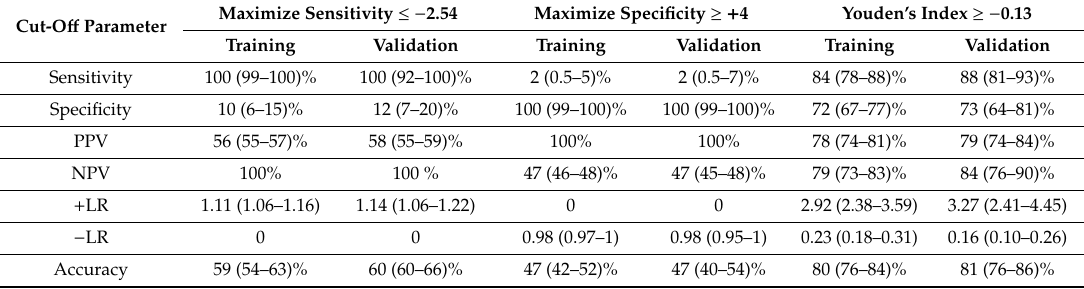
Table 5. Cut-off Selection. Cut-off values were chosen in the training cohort in order to maximize either sensitivity or specificity or according to the Youden’s Index criteria. The same cut-off values were applied to the validation cohorts and showed comparable performance.